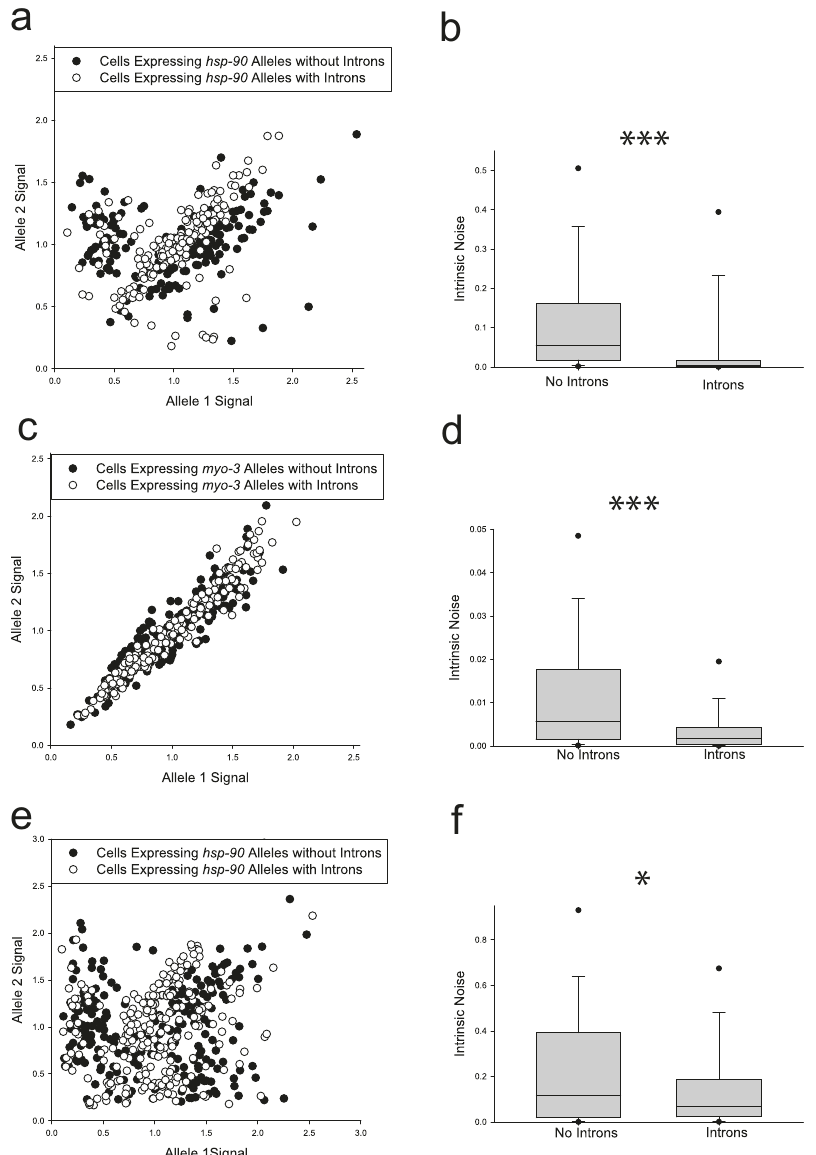
Fig. 2 Stochastic allele bias in muscle cells. Scatter plots show normalized allele expression data for individual cells expressing reporter alleles with and without introns. Boxplots show intrinsic noise measured from each cell for each set of reporter alleles with and without introns. Top of boxplot is 75th percentile, bottom of box is 25th percentile, line is median, top and bottom error bars are 90th and 10th percentile, respectively, and dots are 95th and 5th percentile. a shows a scatter plot of allele expression data from muscle cells expressing fl uorescent alleles with and without introns, controlled by the hsp- 90 promoter. n = 180 cells per group examined over three independent experiments. b shows boxplots of intrinsic noise for each set of alleles in muscle cells from a . c shows a scatter plot of allele expression data from muscle cells expressing fl uorescent alleles with and without introns, controlled by the myo-3 promoter. n = 240 cells per group examined over four independent experiments. d shows boxplots of intrinsic noise for each set of alleles in muscle cells from c . e shows a scatter plot of allele expression data from muscle cells expressing fl uorescent alleles with and without introns, controlled by the hsp- 90 promoter, expressed from a locus on chromosome V instead of chromosome II. n = 180 cells per group examined over three independent experiments. f shows boxplots of intrinsic noise for each set of alleles in muscle cells from e . Statistics: b , d , f Mann – Whitney two-tailed non-parametric test. * p < 0.05, ** p < 0.01, *** p < 0.001. Source data are available in the Source Data fi bias. Our analysis of all alleles sorted by promoter revealed that promoters had a signi fi cant effect on stochastic allele bias (Fig. 6c, P < 0.01 for all comparisons except hsp-16.2 vs. hsp-90 where P < 0.05). Taken together, our data show that allele bias is a type each contributing to an overall setpoint of allele bias. Yet, regardless of the loci, promoters and cell types we tested, introns still affected stochastic allele bias (Figs. 2 and 4).